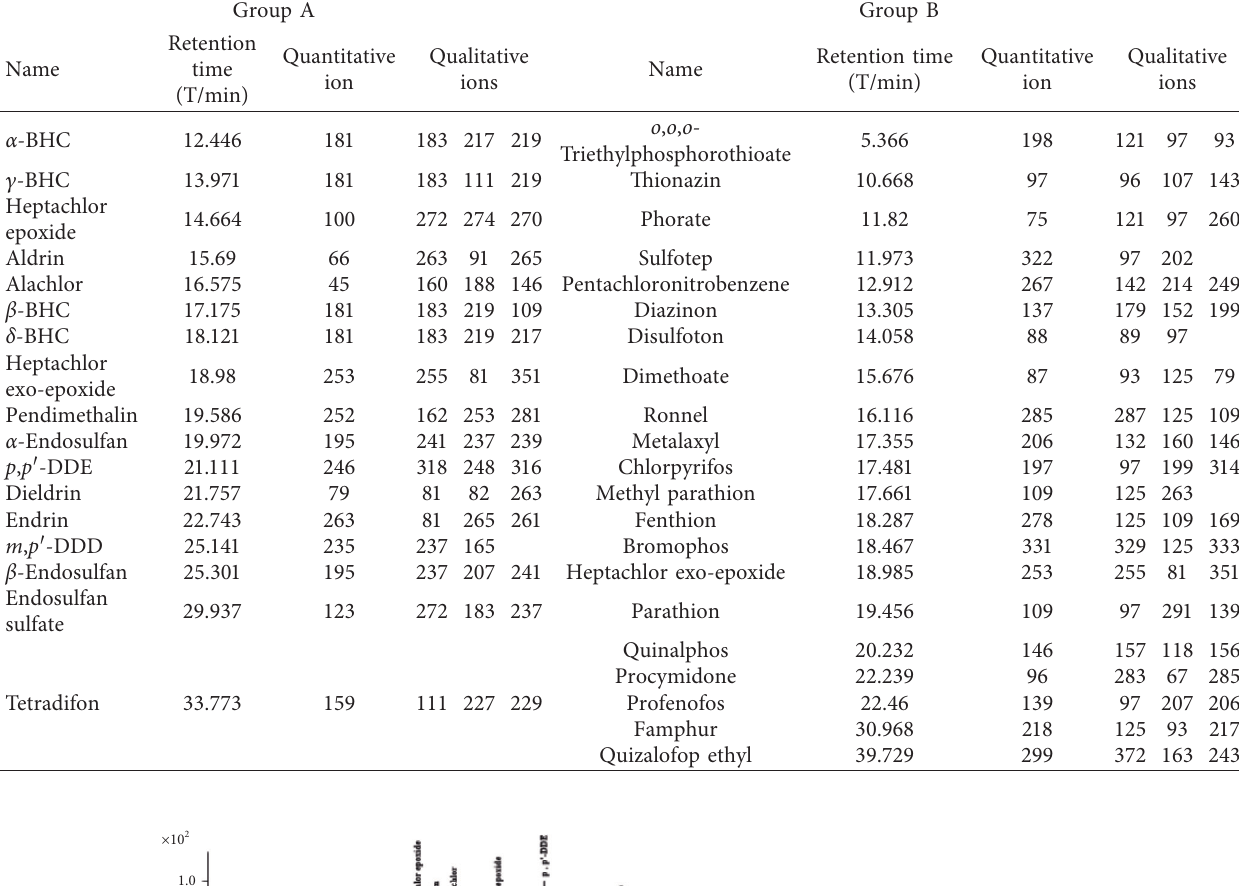
Table 1: Qualitative and quantitative ions of group A and group B pesticides. Group A Group